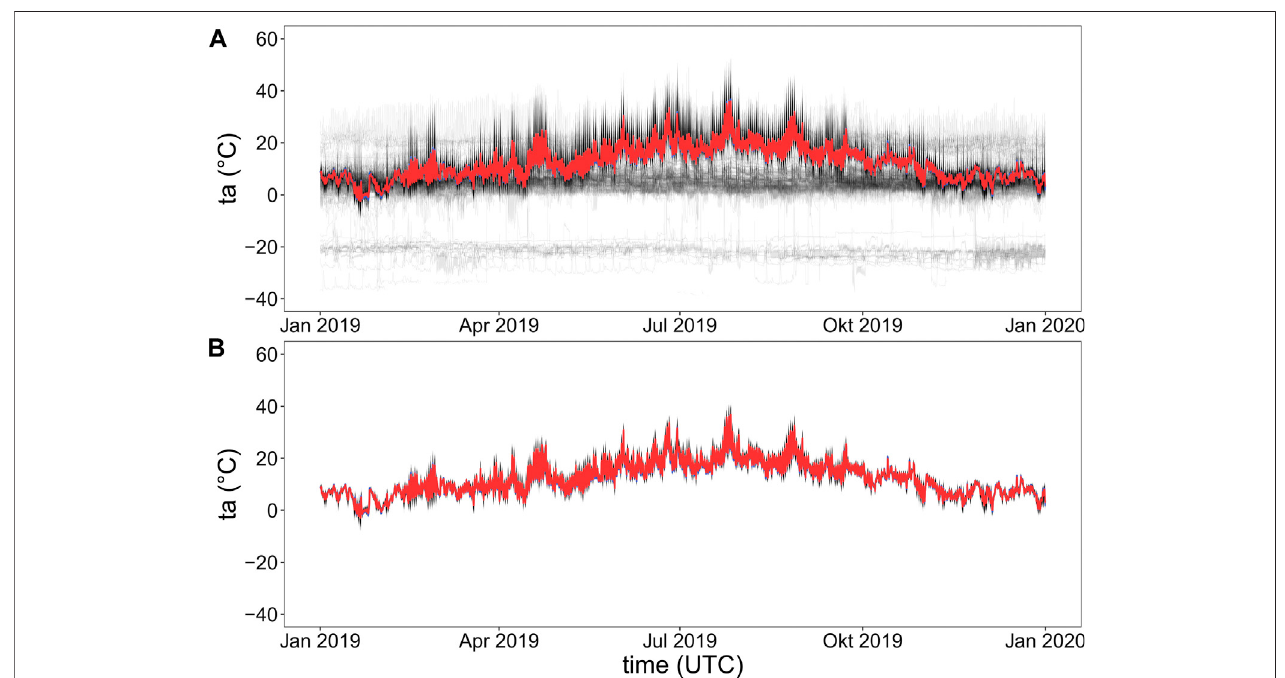
FIGURE 3 | Hourly air temperature ( ta ) in Amsterdam during 2019. Each grey line corresponds to data from a single CWS, the red line displays the spatial median across all CWS, the blue line the median across all PRWS (barely visible as similar to red line). Sub- fi gure (A) shows raw CWS data, sub- fi gure (B) CWS data at QC level m5 of CrowdQC+ with default settings (cf. Table 2